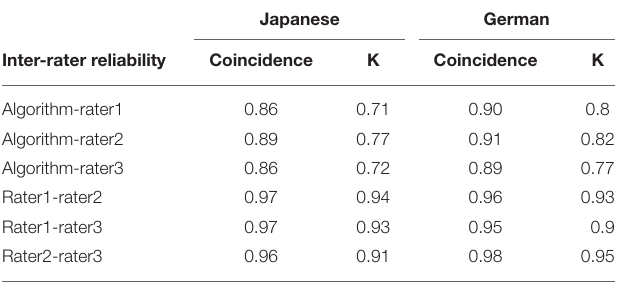
TABLE 1 | Inter-rater reliability tests for the Japanese and German Wikipedia language